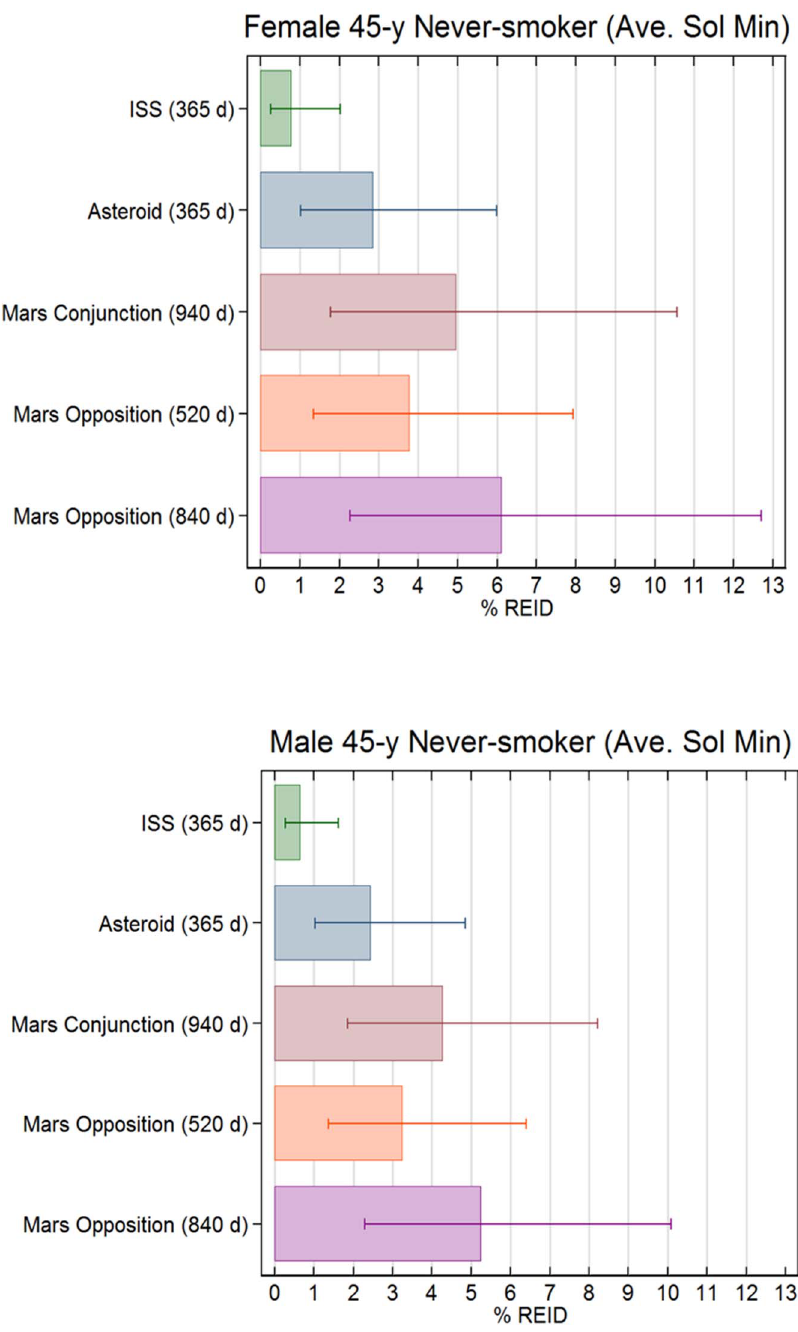
Figure 5. Comparison of %REID from cancer and circulatory diseases combined for several space exploration missions. (A) Estimates are shown for 45-y old female and (B) male never-smokers. Calculations assume 20 g/cm 2 and 10 g/cm 2 aluminum shielding for transit vehicle and martian surface habitat, respectively. Error bars reflect the 95% confidence intervals.